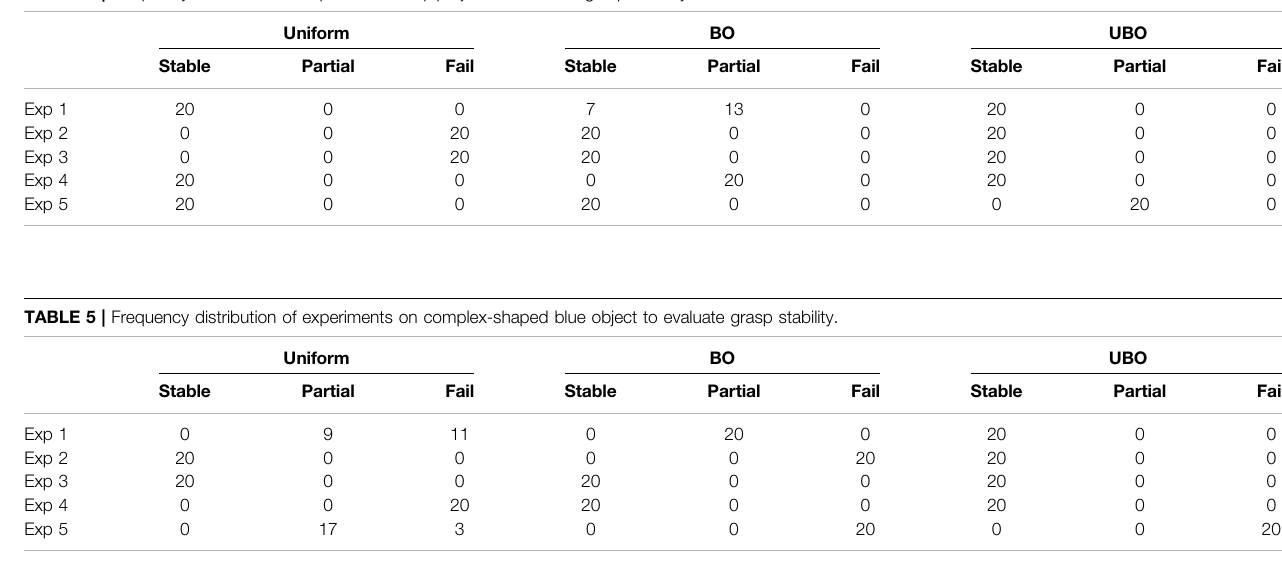
TABLE 4 | Frequency distribution of experiments on pipe joint to evaluate grasp stability.